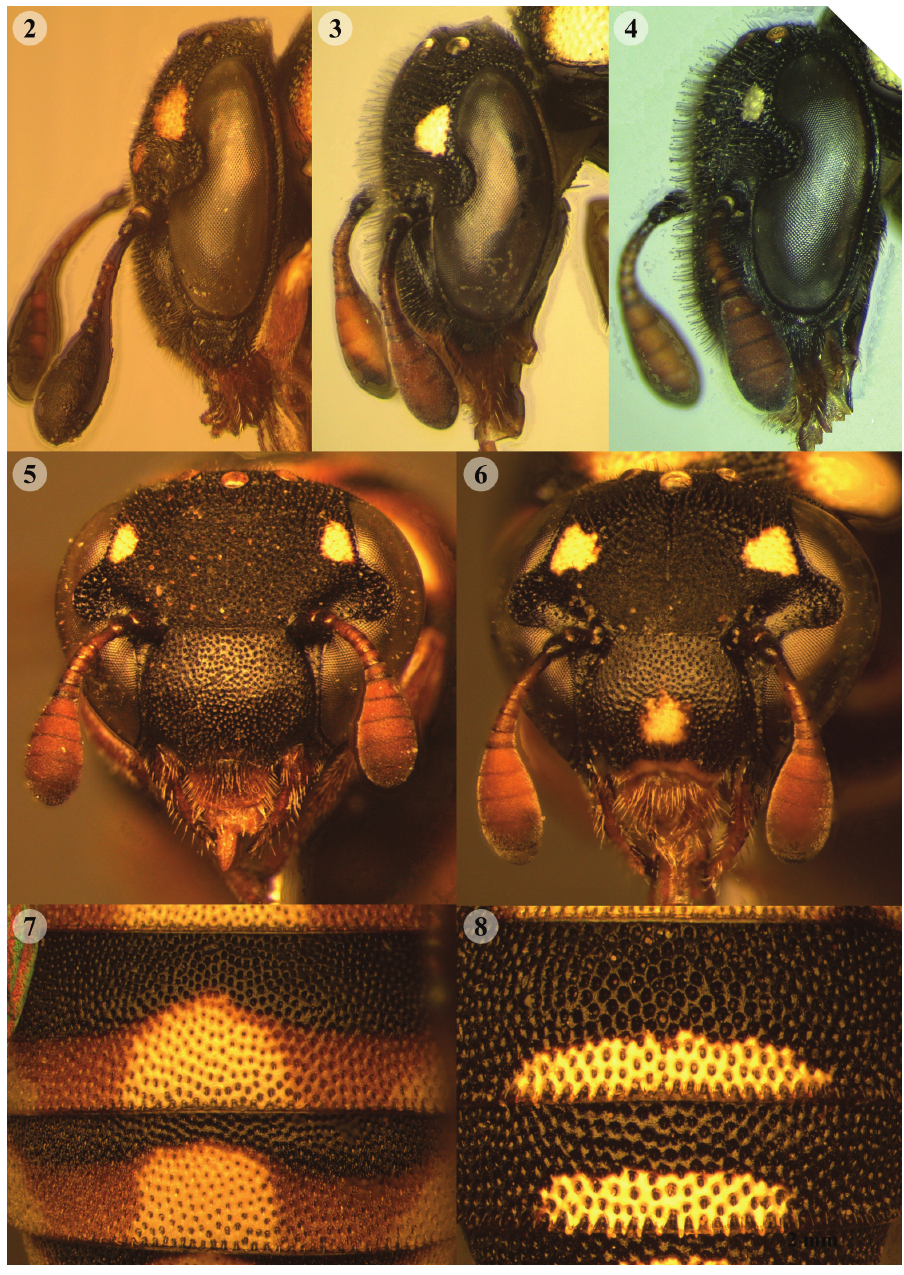
Figures 2–8. 2–4 Head of female in lateral view showing pilosity on frons and clypeus 2 C. fischeri (dbM No. 3065) 3 C. andreasmuelleri (dbM No. 3072) 4 C. spinosus (dbM No. 3428). 5–6 Head of female